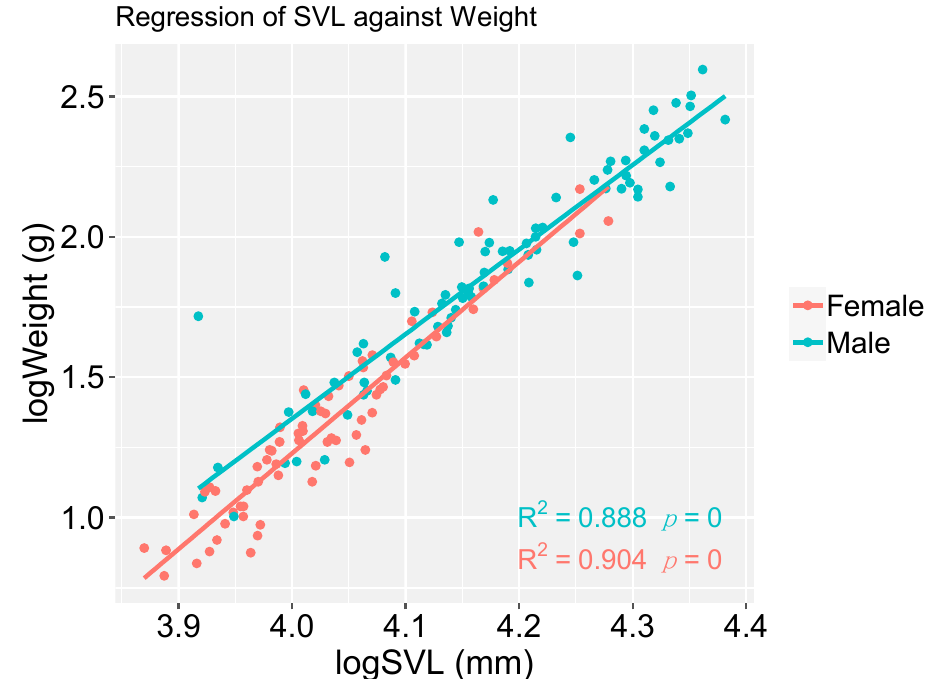
Figure 2. Linear regression of SVL logarithm (logSVL) against body mass logarithm (logWeight) in both males and females of Teira dugesii from Madeira Island.